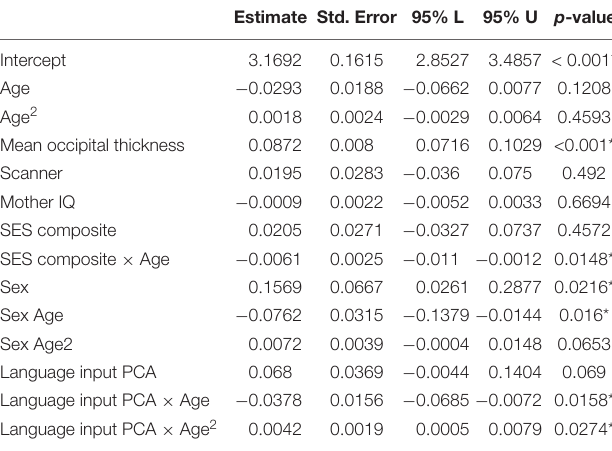
TABLE 3 | Results of a linear mixed model analysis for the relationship between parental language input PCA (word tokens and decontextualized utterances) and cortical